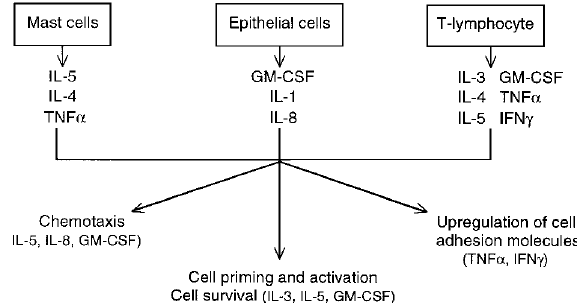
FIG. 3. Role of cytokines in the modulation of eosinophil function in allergy.